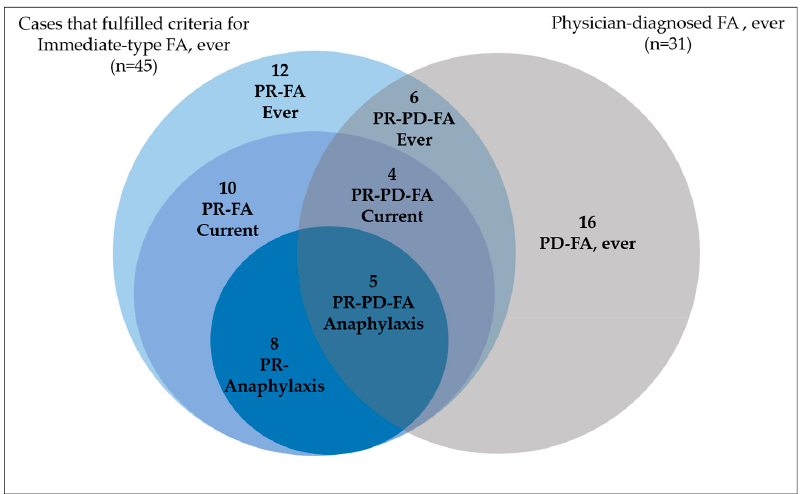
Figure 1. Characteristics of the cases that met criteria for immediate-type FA, ever, and/or PR-PD FA ever. Acronyms used: FA: Food allergy; PR: Parent-reported; PR-PD: Parent-reported physician- Acronyms used: FA: Food allergy; PR: Parent-reported; PR-PD: Parent-reported diagnosed.